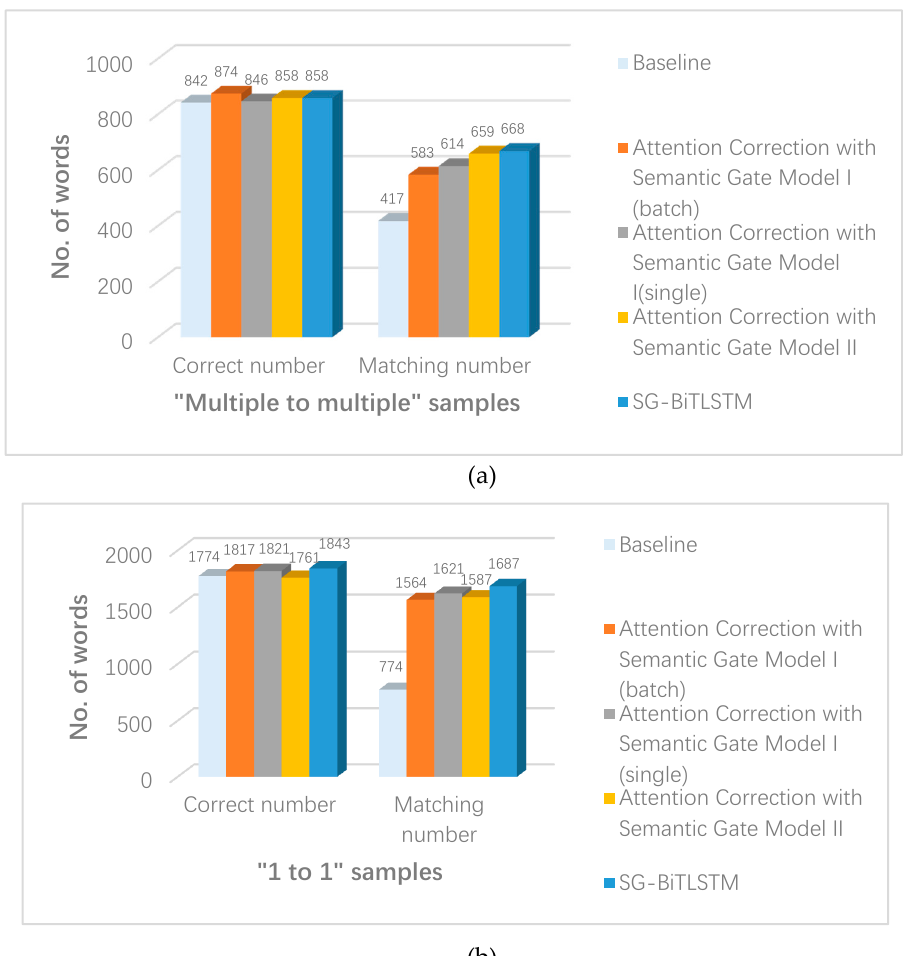
Figure 16. Location analysis of the samples. ( a ) Location analysis of the “multiple to multiple” samples; (b) location analysis of the “1 to 1” samples.